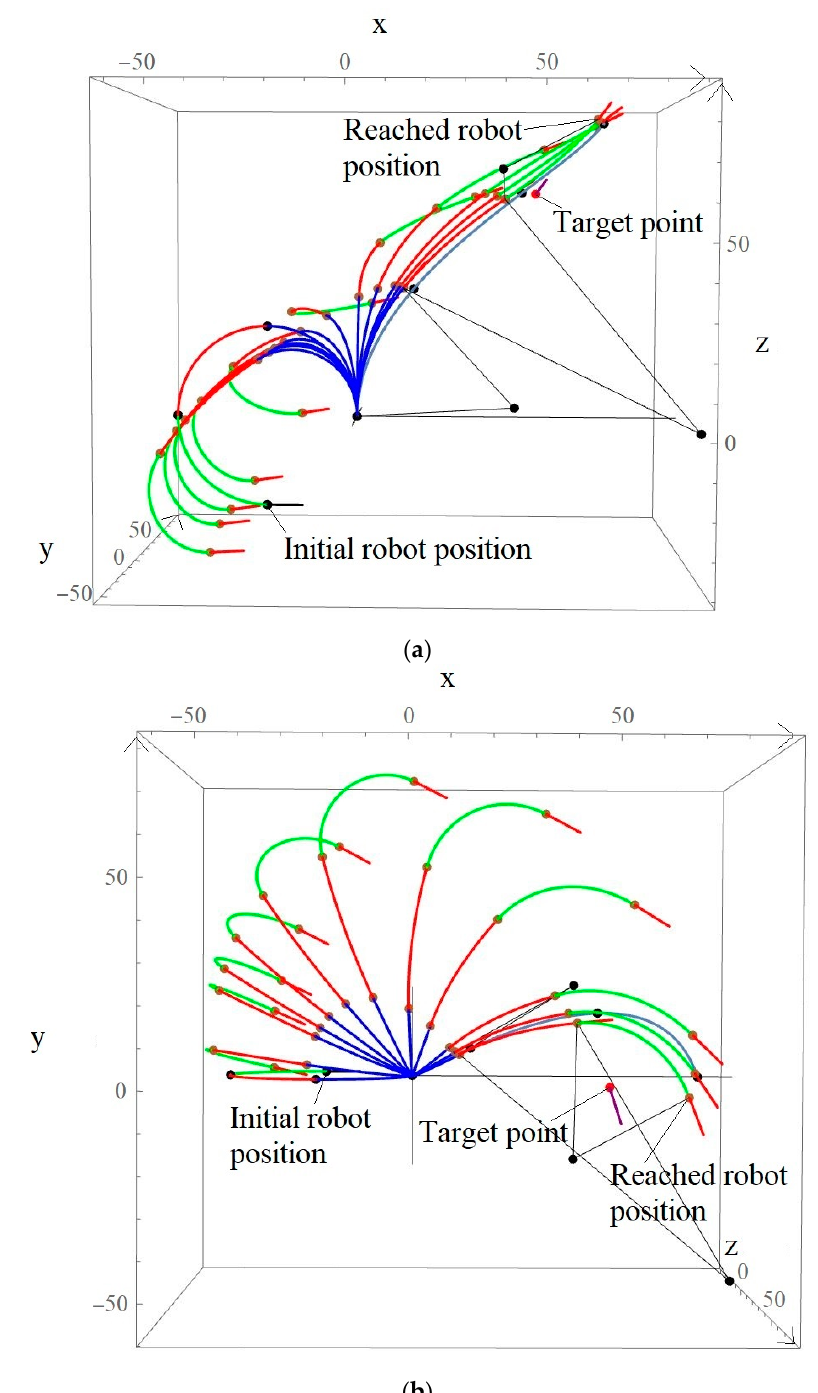
Figure 24. Robot segments motion from the initial position to the target position. The light blue curve illustrates the robot spine curve. The calculated robot segment arc curves are blue, red, and green: ( a ) robot motion side-view, when the robot is bent in the initial position; ( b ) robot motion top-view, when the robot is initially bent.